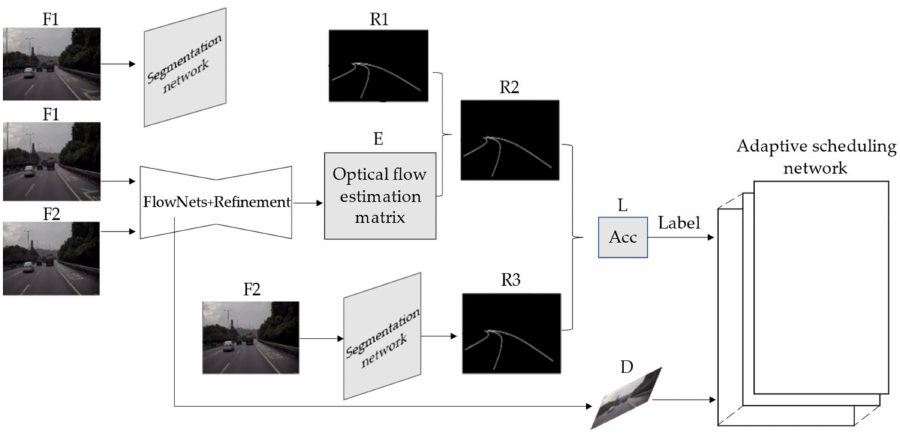
Figure 10. Training process of adaptive scheduling network.